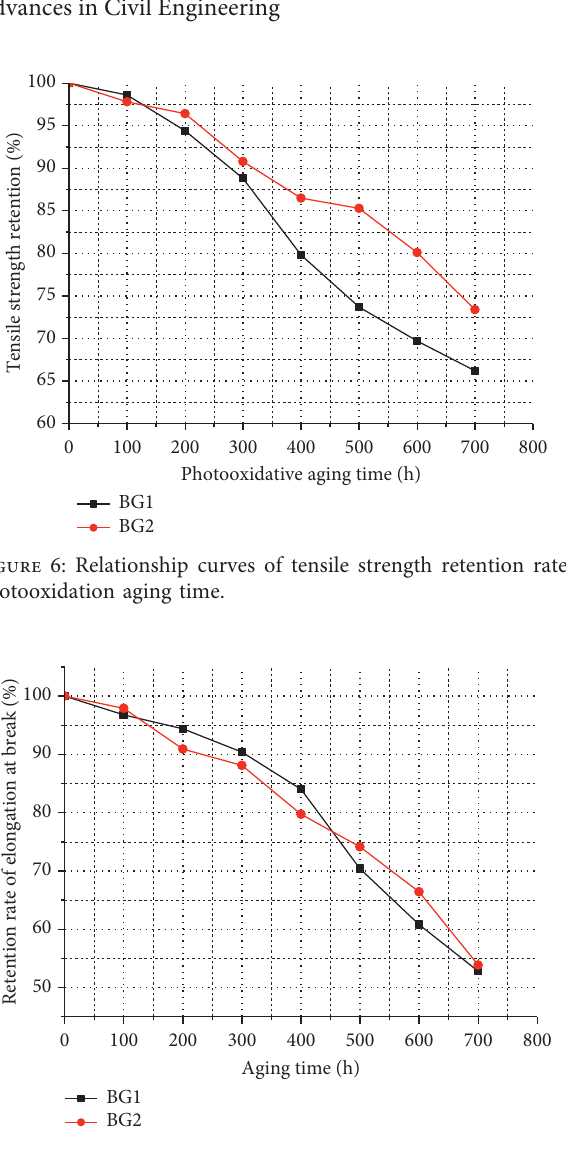
Figure 7: Relationship curves of retention rate of elongation at break-photooxidation aging